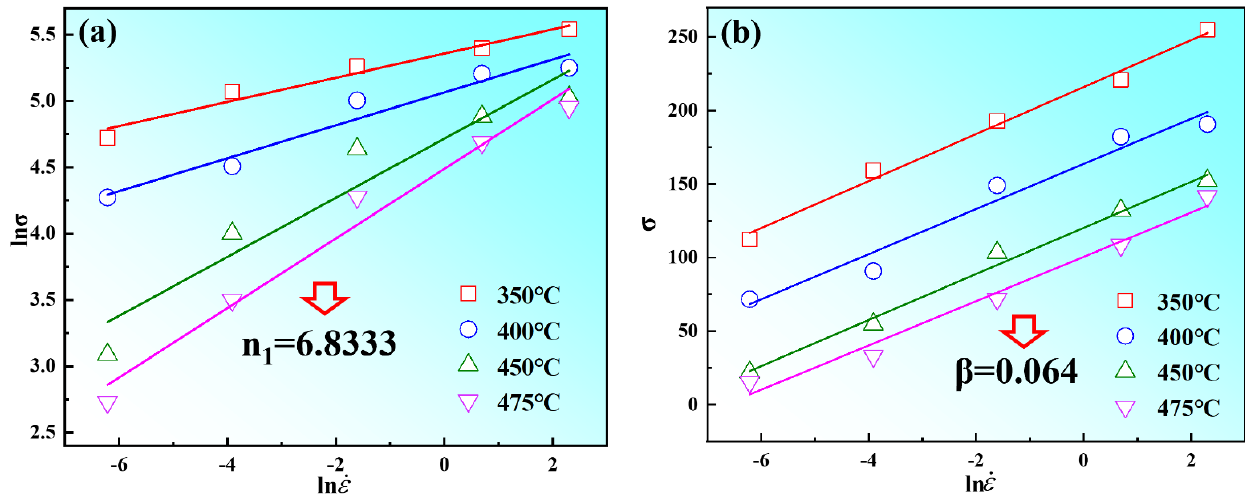
Figure 7. The linear relationship between stress and strain rate: ( a ) the relationship between ln σ and ln 𝜀̇ ; ( b ) the relationship between σ and ln 𝜀̇ .